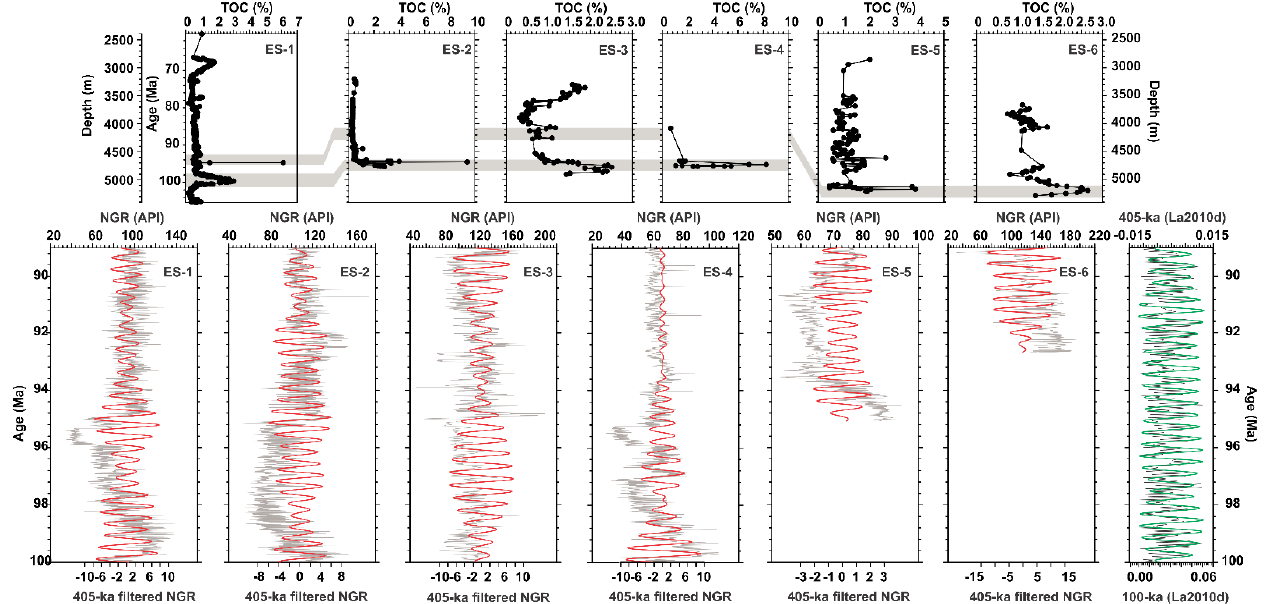
Figure 2. Propagation of the ES-1 astronomical age model to the other wells of the Espírito Santo Basin. The graphs at the top show the TOC (%) data for each well and the correspondence of the peaks between them. The graphs at the bottom show the filtered 405 ka cycle from the NGR of each well.